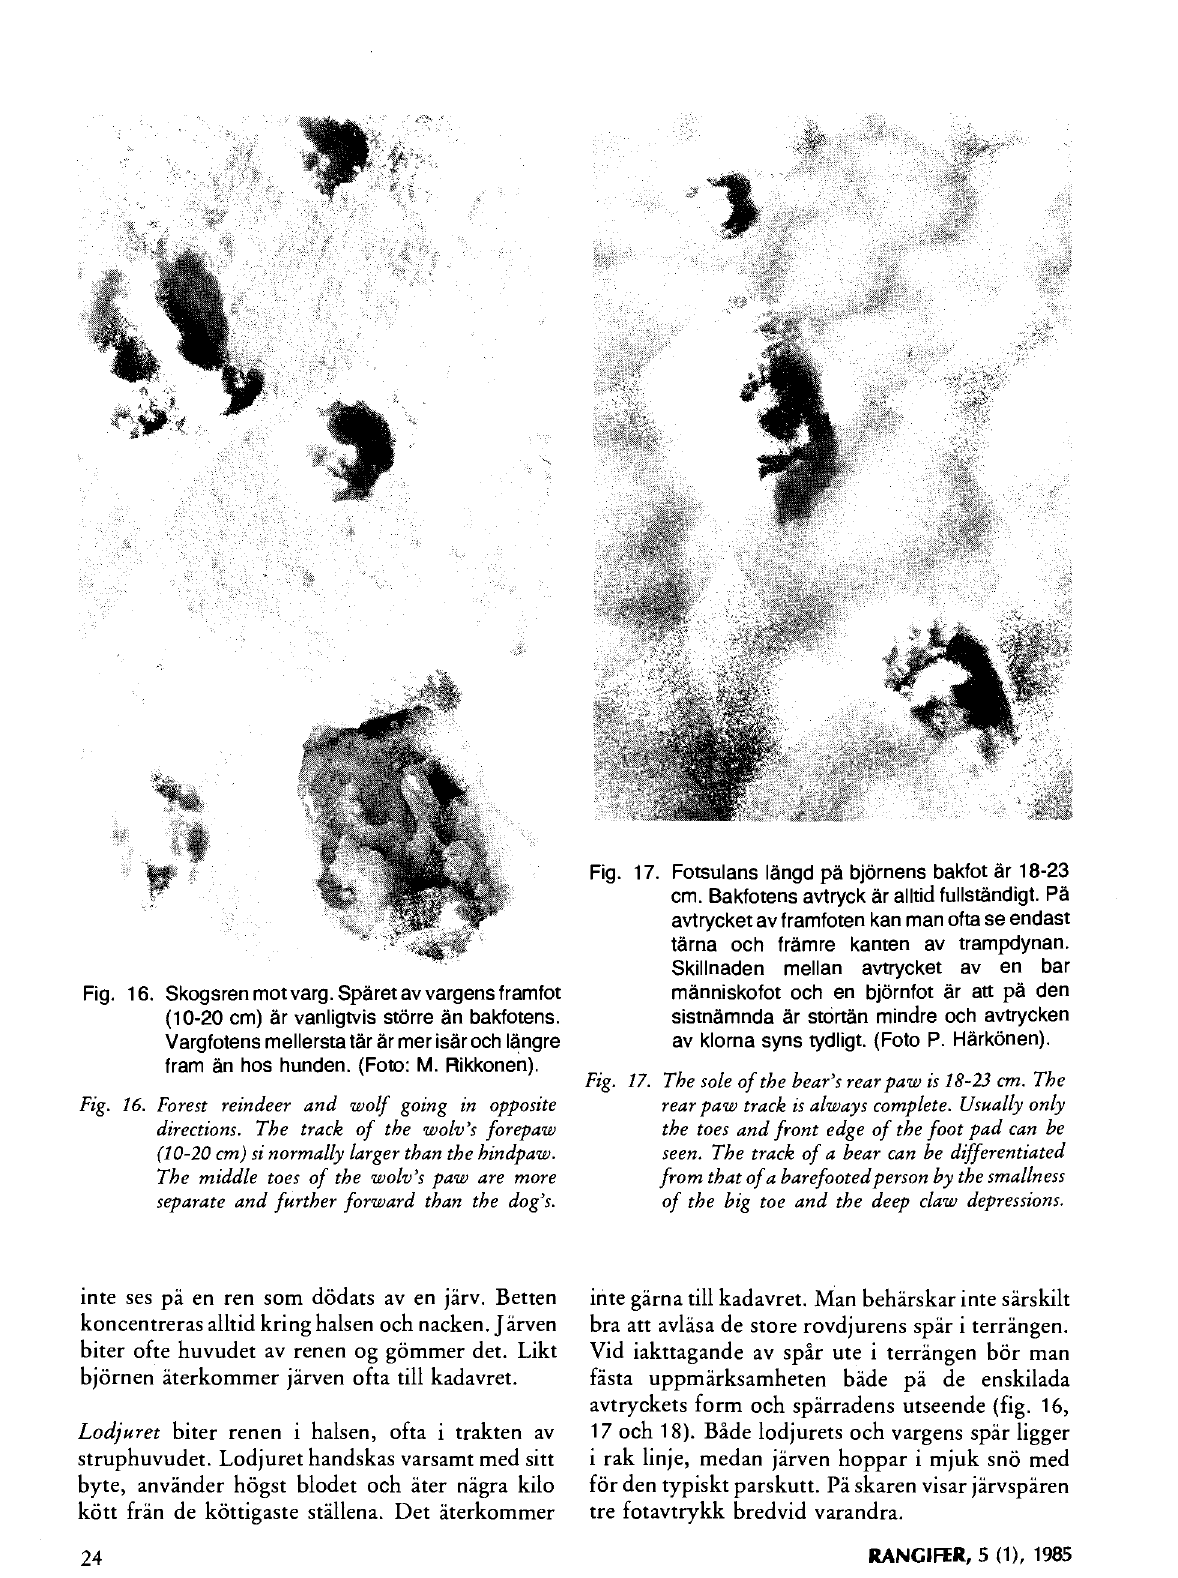
Fig. 17. Fotsulans långd på bjdrnens bakfot år 18-23 cm. Bakfotens avtryck år alltid fullståndigt. På